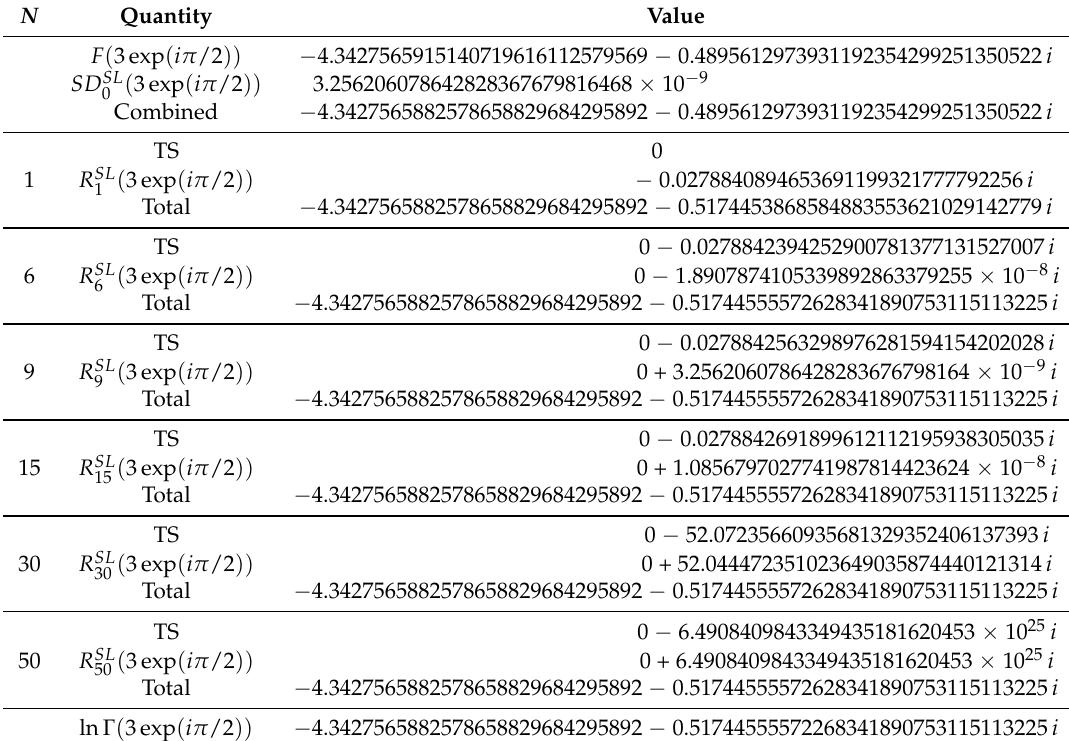
Table 4. ln Γ ( 3exp ( i π /2 )) via (25) for various values of N